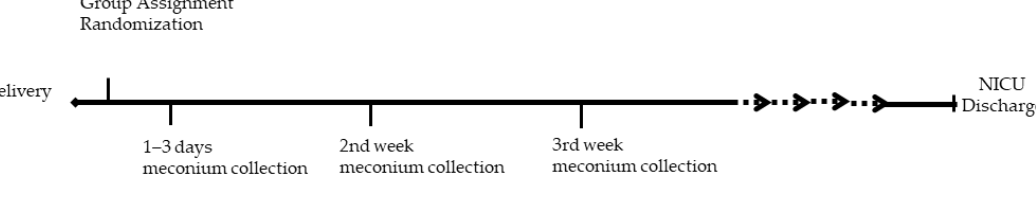
Figure 8. Study Collection Timeline.